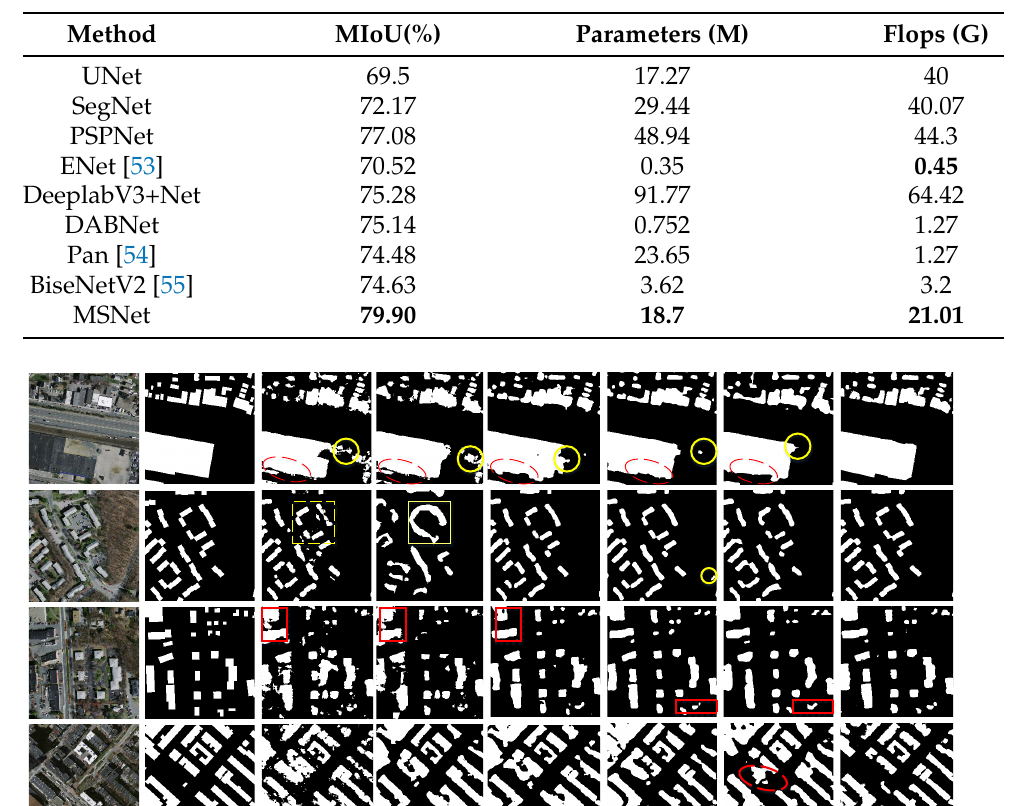
Table 4. Generalization experiment on the public land-cover dataset.